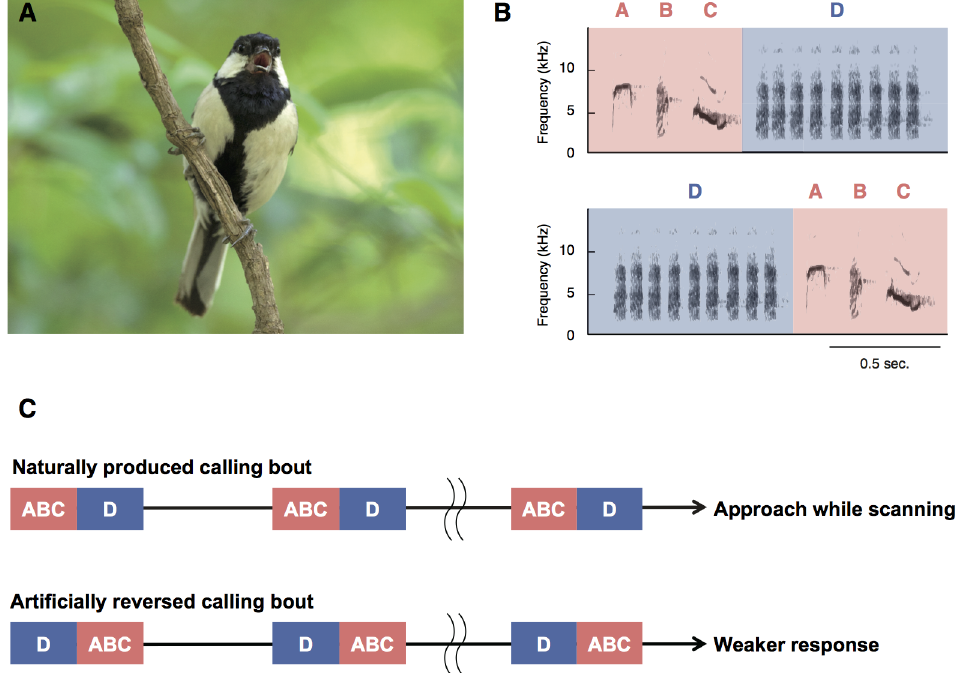
Fig 1. Schematic representation of experimental design. ( A ) Japanese tit. ( B ) Sound spectrogram of naturally produced ABC-D and artificially reversed D-ABC sequence. ( C ) Schematic representation of playback stimulus and responses (Experiment 2 in [5]). A different response to ABC-D and D-ABC sequences indicates that tits recognize call ordering when decoding the sequences. Photo credit : Toshitaka N . Suzuki .